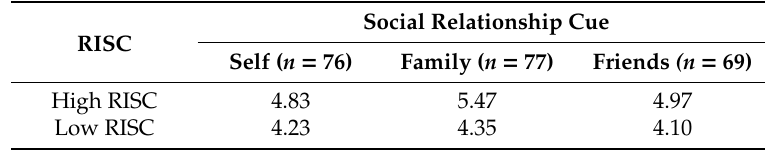
Table 6. The means of